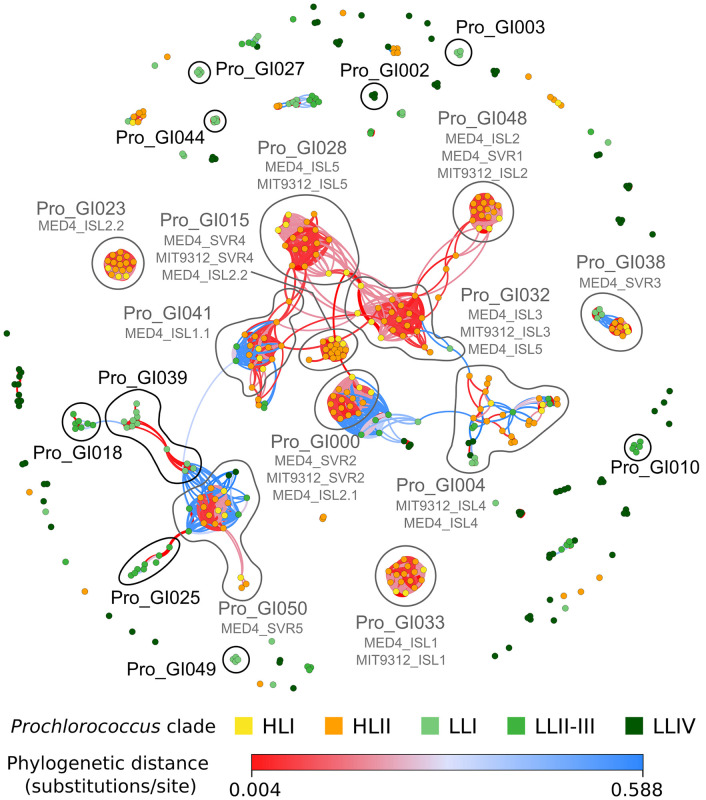
Network of shared gene islands between all Prochlorococcus strains analyzed in this study. Each node corresponds to a genomic island in a given strain, the gene content of which is listed in Supplementary Table S5. Edges were colored according to the phylogenetic distance between strains, with red indicating closely related strains and blue more distantly related strains, as indicated in the color bar. Edge width corresponds to the Jaccard distance between islands based on gene content. Nodes were colored based on Prochlorococcus clade. Modules cited in the text are surrounded with a gray line for those containing islands already described in the literature [subtitled with their names in Coleman et al. (2006) and Dufresne et al. (2008)] and a black line for new modules described in the present study. The gene and genomic island composition of each module is described in Supplementary Table S6.